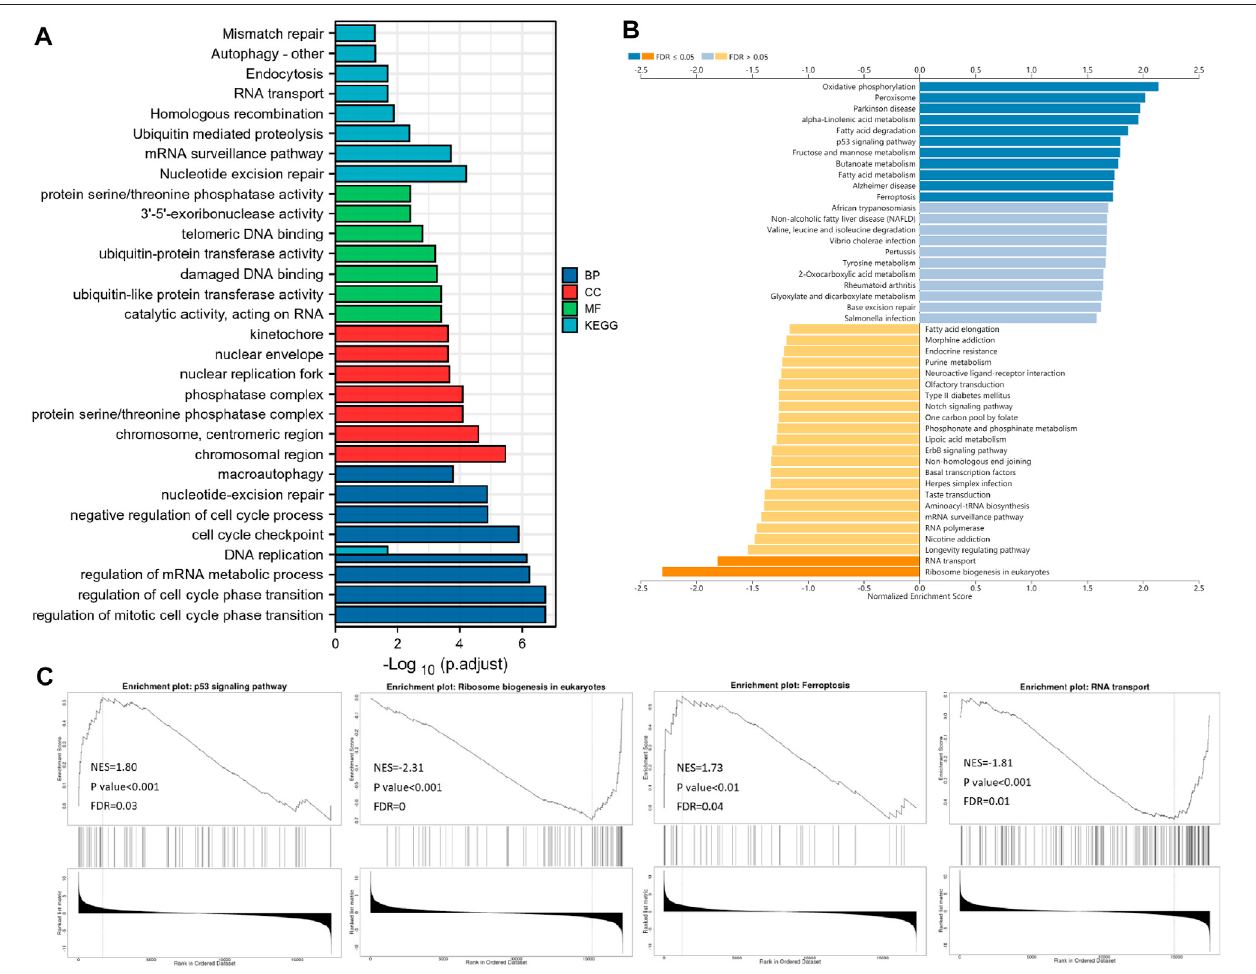
FIGURE 5 | Functional enrichment analysis. (A) Bar plot displays the GO and KEGG analysis of the top 800 genes, which show the most positive correlation with SRR by data from TCGA. LinkedOmics-based gene set enrichment analyses (GSEA) of SRR-associated pathways are shown in (B) and (C)